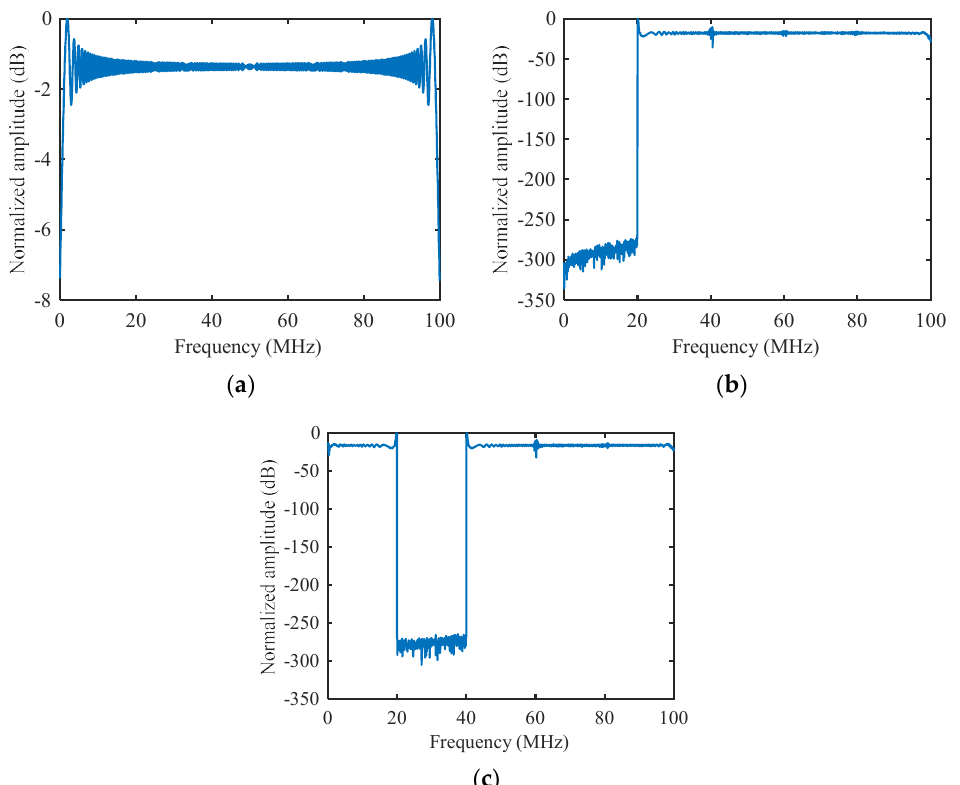
Figure 16. Normalized spectra of the ( a ) LFM waveform, ( b ) waveform designed using sensed interference information and ( c ) waveform designed using the OS-ELM-FP-based interference frequency